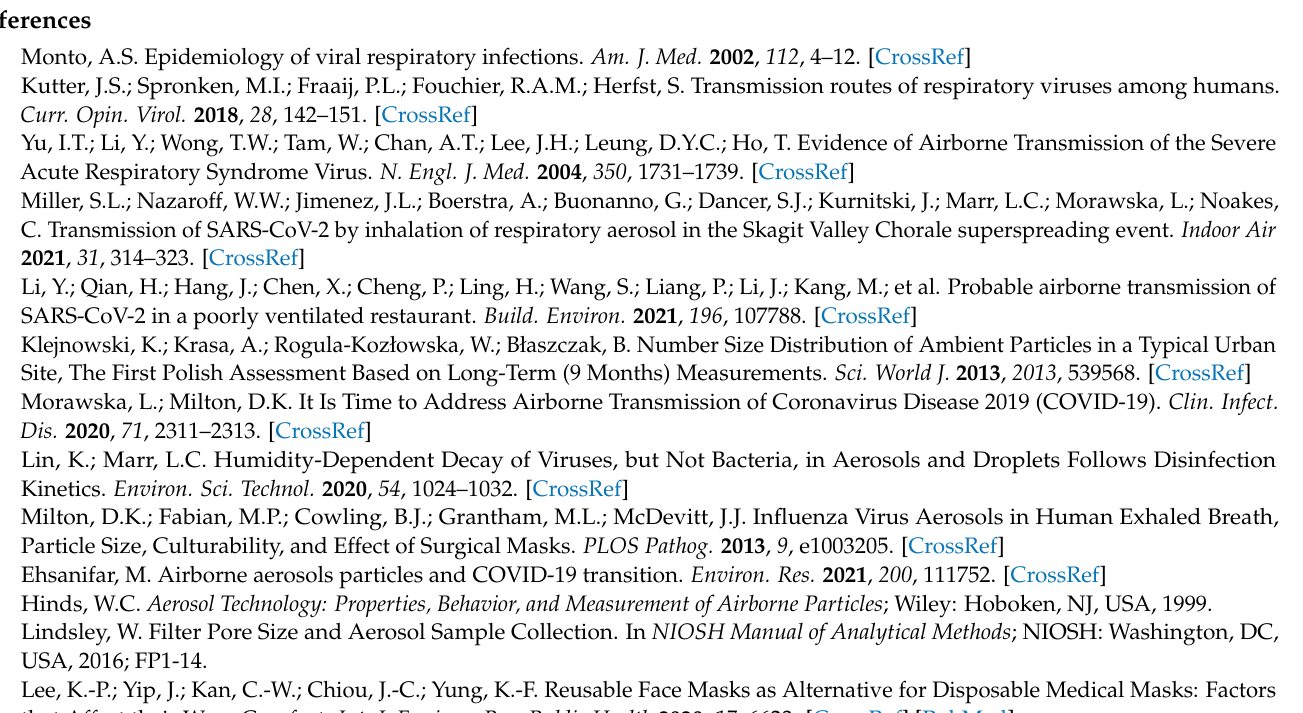
Figure S3: Filtration efficiency results for single layered materials as a function of relative humidity. Bar colors represent the corresponding RH values with the results plotted at the average filtration efficiency from three experimental runs with the error bars representing the standard deviation; Figure S4: Filtration efficiency results for layered materials as a function of relative humidity. Bar colors represent the corresponding RH values with the results plotted at the average filtration efficiency from three experimental runs with the error bars representing the standard deviation.; Figure S5: Quality factor results for layered materials when face velocity is varied. The quality factor results use the average filtration efficiency and pressure drop readings taken from three experiments to calculate three individual quality factor values. Error bars in the figure represent the standard deviation across these three quality factor values while the bar colors represent the corresponding face velocity values; Table S1: Material list, description, and average filtration efficiency, pressure drop, and quality factor values. Materials are listed from highest quality factor to lowest. Average and standard deviation values are calculated across three